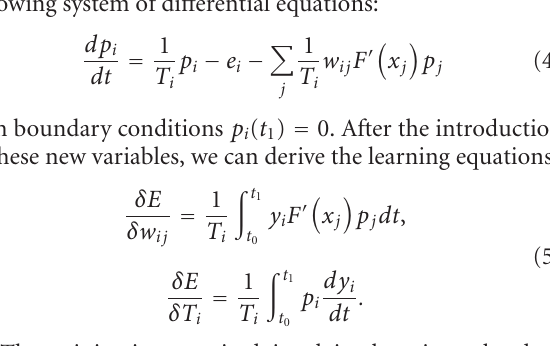
the artificial neurons. The adaptive time constants make it dynamic. Additional information can be found in